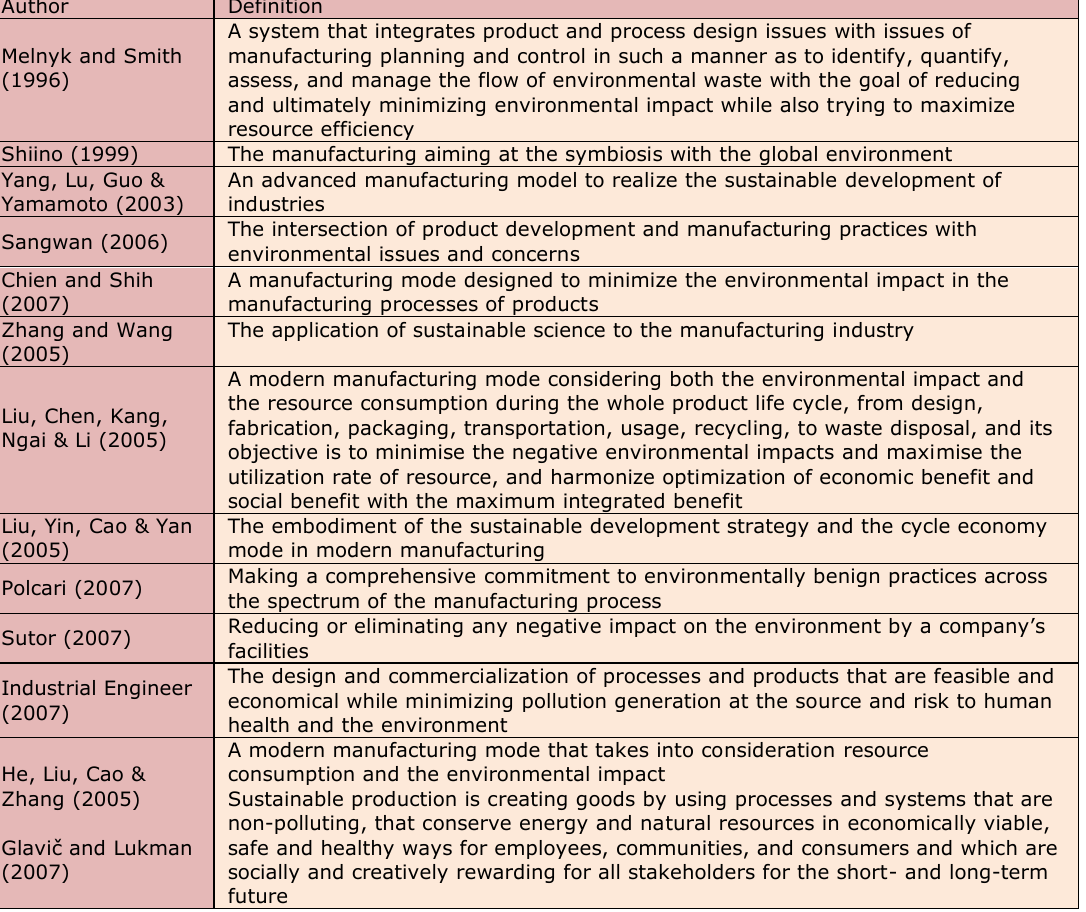
Table 1. Definitions of green